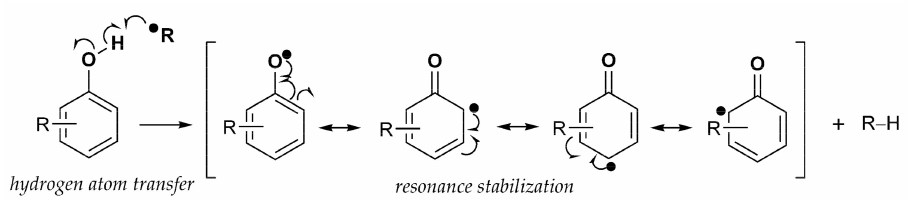
Figure 2. Formation and stabilization of substituted phenoxy